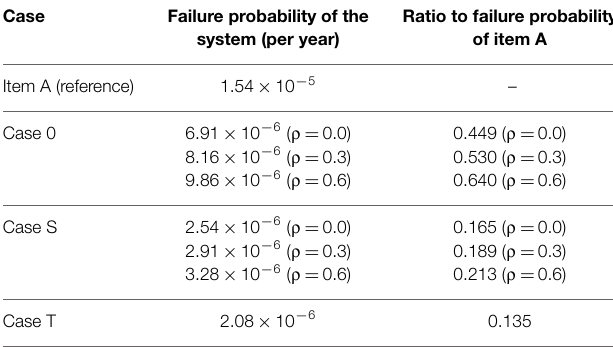
TABLE 5 | Calculated failure probabilities for the system